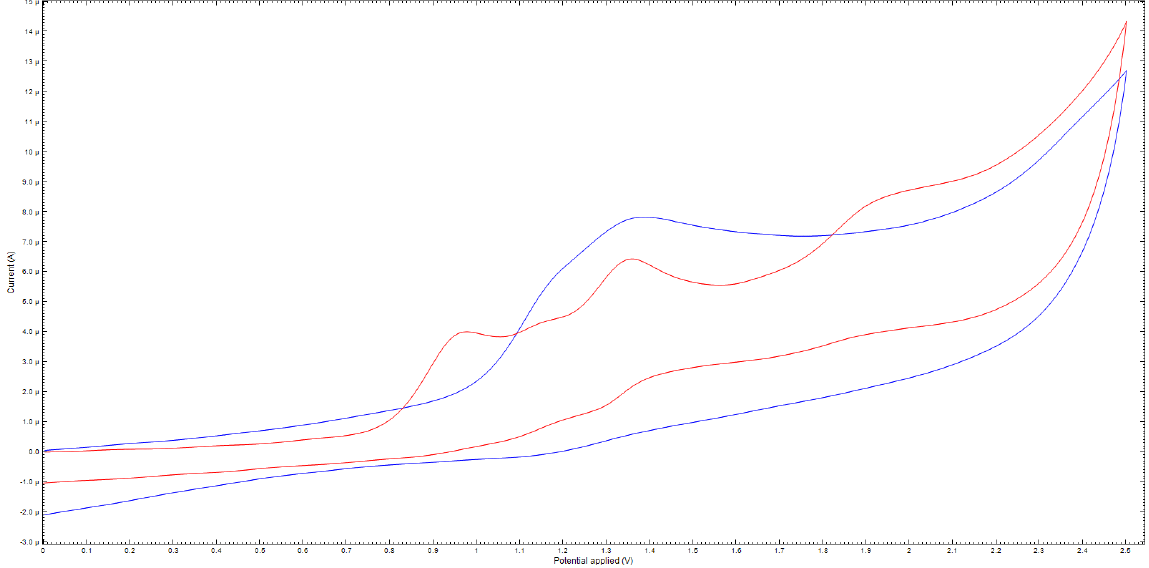
Figure 3 . Cyclic voltammogram of 8b (blue) and 8e (red), 5 × 10 − 3 M .